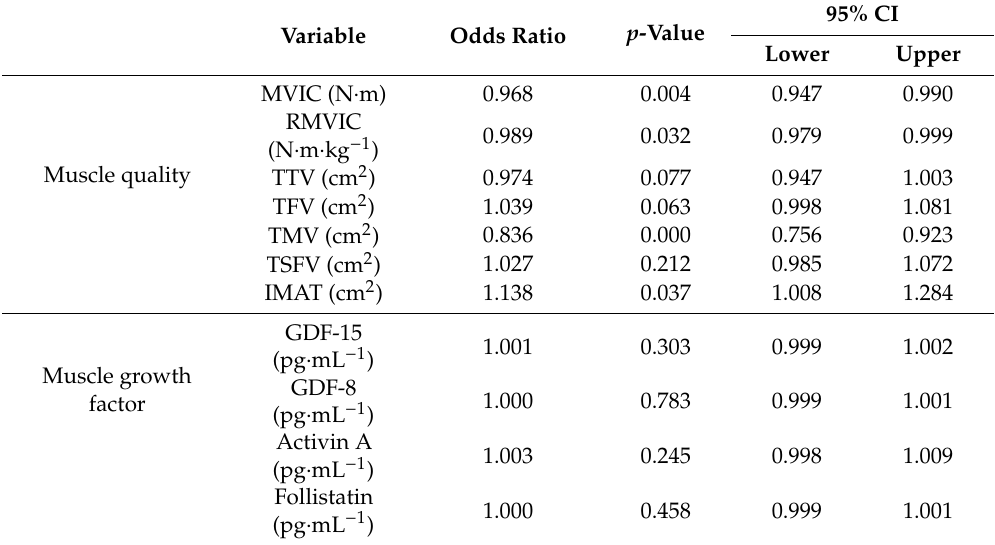
Table 4. Comparison of muscle quality and biomarkers between sarcopenic and non-sarcopenic groups. 95% CI Variable Odds Ratio p -Value Lower Upper MVIC (N · m) 0.968 0.004 0.947 0.990 RMVIC 0.989 0.032 (N · m · kg − 1 ) Muscle quality